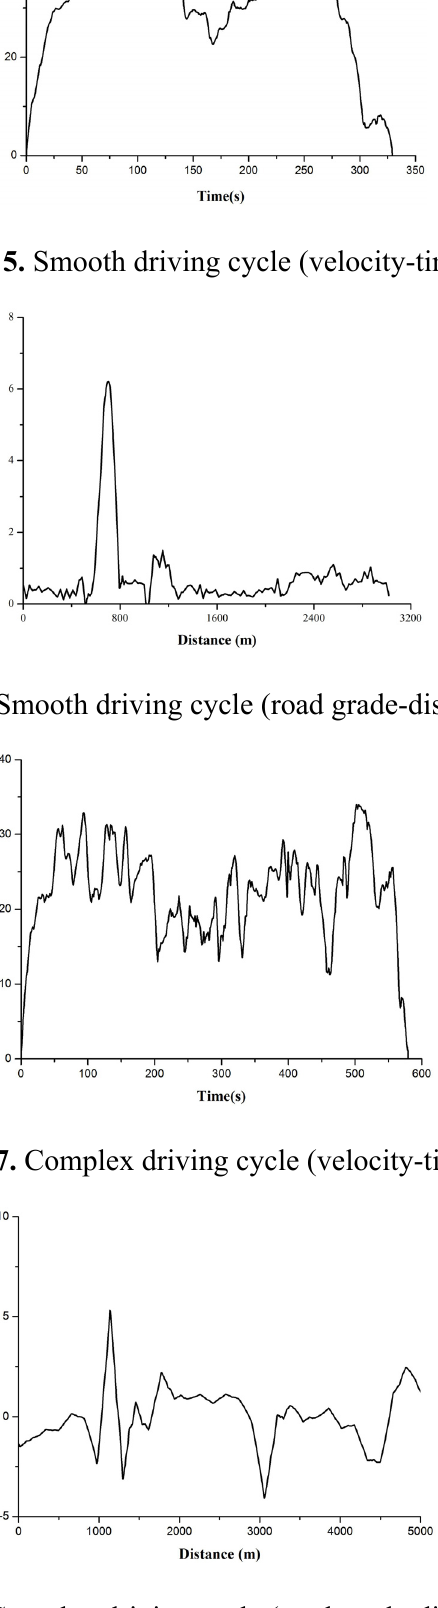
Figure 8. Complex driving cycle (road